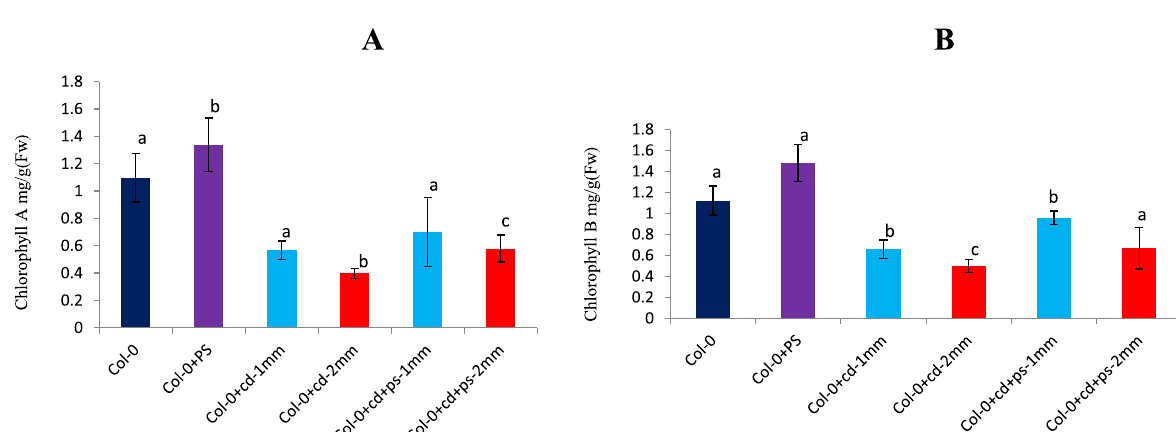
Fig. 5 Effects of P. fluorescens on chlorophyll a and b content of Arabidopsis under different CdCl2 concentrations. Values are means and bars indicate SDs ( n 6) columns with a , b , and c letters indicate statistically significant difference at P < 0.05 (Duncan =